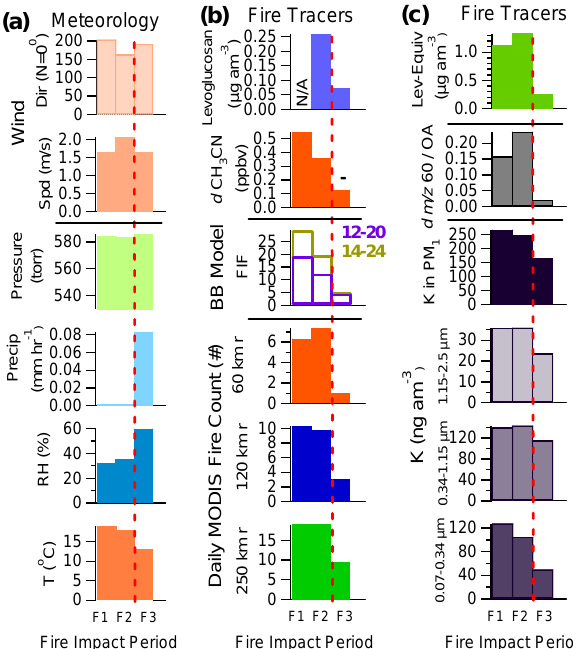
Fig. 8. Fire period analysis graphs, comparing the average values of different parameters for the high fire (F1, F2) and low fire (F3) periods, including (a) meteorology: wind direction, wind speed, ambient pressure, precipitation, RH, and T ; (b) BB tracers: GC-MS levoglucosan, gas-phase 1 CH 3 CN above background, fire impact factors (FIF 12 − 20 and FIF 14 − 24 ), MODIS fire counts (at 60, 120 and 250km radii), (c) additional BB tracers: AMS levoglucosan- equivalent mass, AMS m/z 60/OA, total K in PM 1 , total K in each of the three size bins of the PIXE measurements. (Legend: −= less than 30% time series, N/A = no